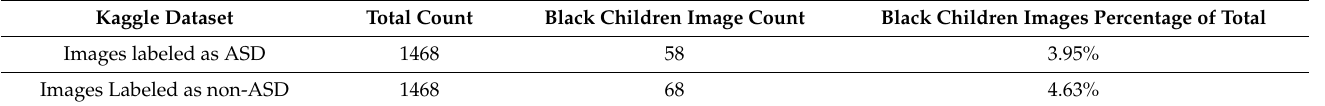
Table 8. Black children image count in the Kaggle dataset.